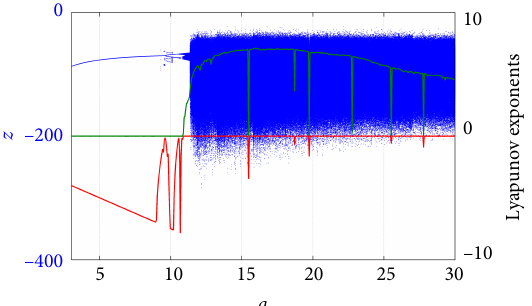
Figure 2: The bifurcation diagram and the Lyapunov exponents by varying 𝑎